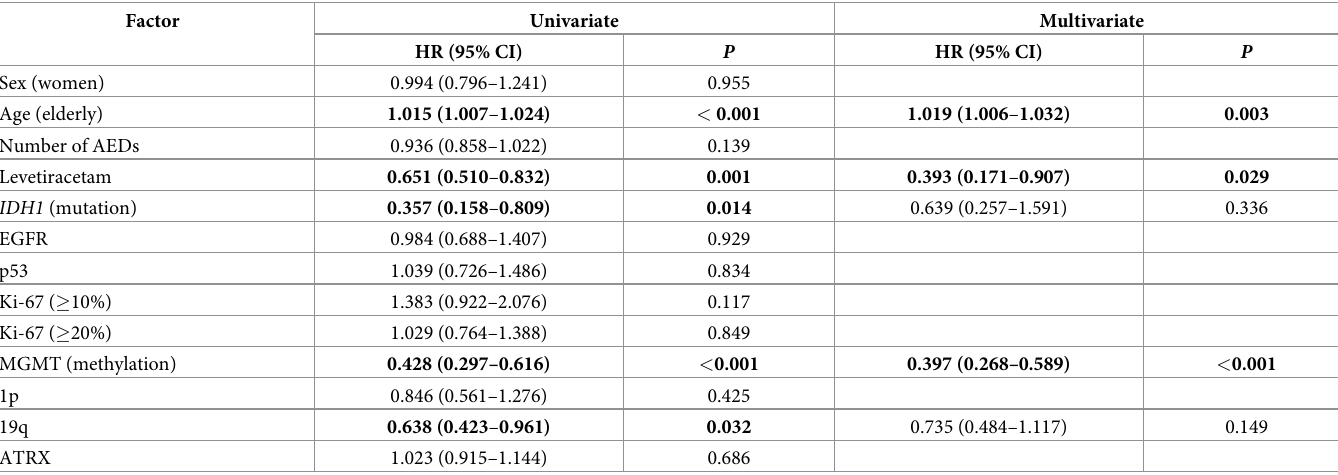
Table 3. Baseline risk factors for the overall survival of patients with